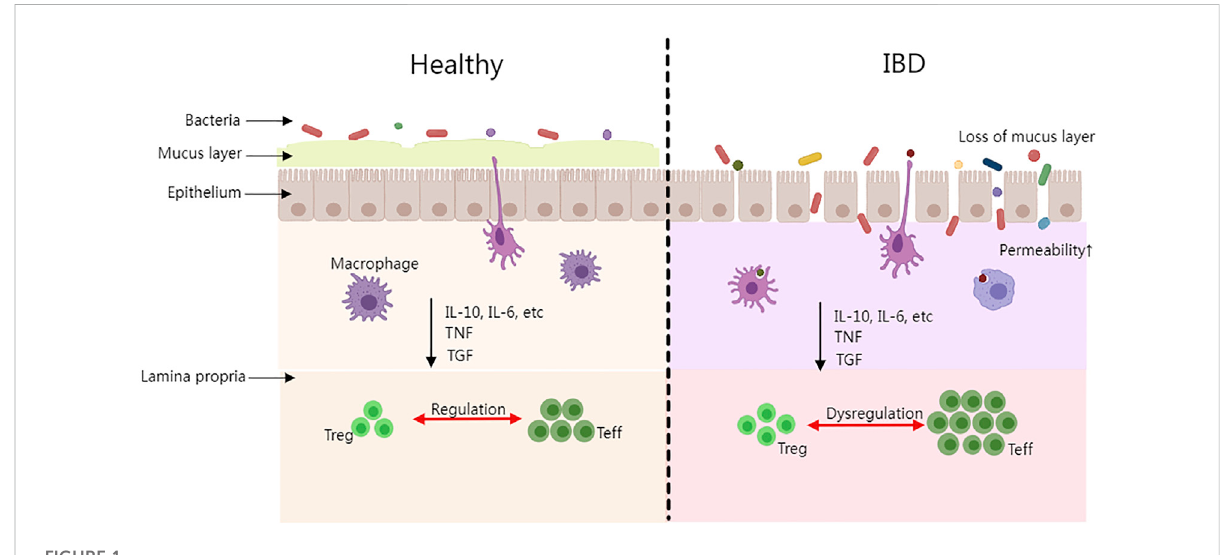
FIGURE 1 The intestinal difference between healthy people and IBD patients. (Treg, regulatory T cell; Teff, effector T cell; IL, interleukin; TNF, tumor necrosis factor; TGF, and transforming growth